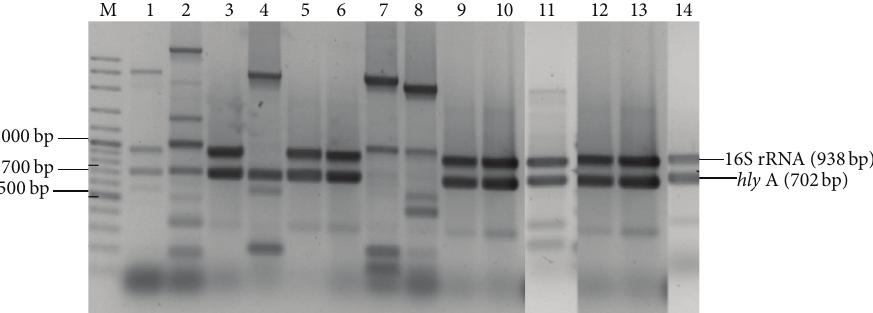
Figure 1: Agarose gel electrophoresis showing electrophoretic mobility of PCR products obtained following amplification of the 16S rRNA gene (938 bp) and listeriolysin O encoding gene ( hly A) (702bp) from different Listeria monocytogenes isolated from raw milk and milk products. Lane M: 100 bp ladder; Lane 1: positive control ( Listeria monocytogenes ATCC 19155); Lane 3: Listeria monocytogenes (LM) isolate ZKMM84;Lane5:LMSGHR30;Lane6:LMSGSK1;Lane9:LMZKJR56;Lane10:LMSGHR39;Lane11:LMZKMR75;Lane12:LMSGMM87;